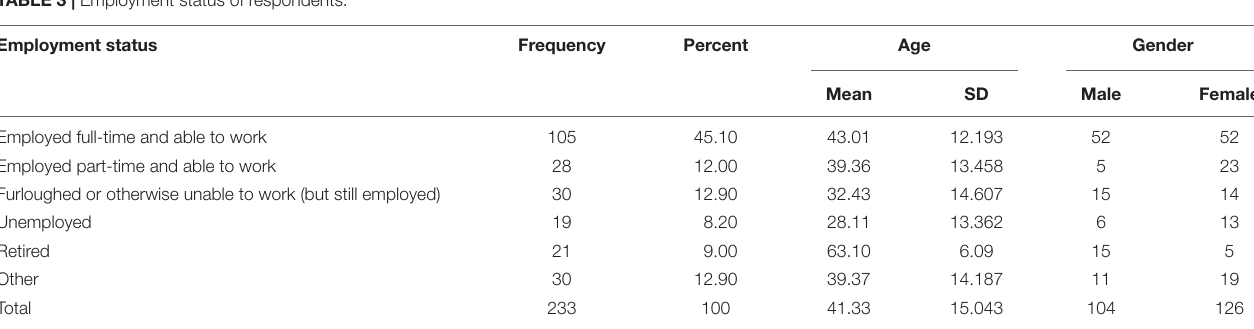
TABLE 3 | Employment status of